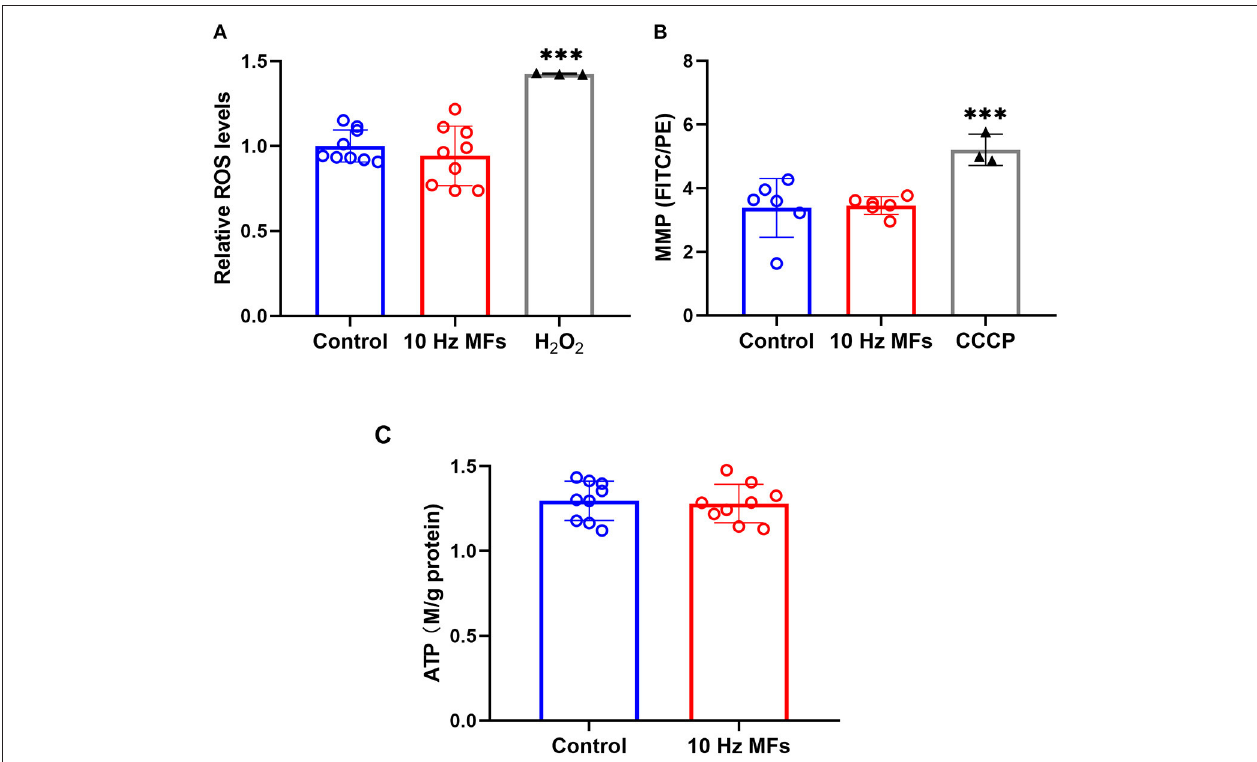
FIGURE 5 | The effect of 10Hz pulsed MFs exposure on ROS, MMP, and ATP levels in 2BS cells. (A) Relative intracellular ROS levels were determined by H 2 DCFDA, (B) MMP determined by JC-1, and (C) ATP concentration in 2BS cells of control and 10Hz pulsed MFs exposure group. Hydrogen peroxide (H 2 O 2 ) and CCCP were applied as the positive control, respectively. Data were presented as mean ± SD. *** P < 0.001. MFs, magnetic fields; ROS, reactive oxygen species; H 2 DCFDA, 2,7-dichlorodihydrofluorescein diacetate; MMP, Mitochondrial membrane potential; ATP, adenosine 5 ′